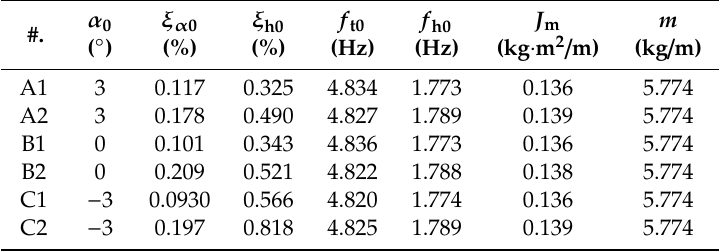
Figure 3. The flat closed-box bridge deck (unit: mm). Table 1. Main dynamic parameters of aeroelastic tests. α 0 is wind attack angle in still air; f t0 and f h0 are linear torsional and heaving frequency in still air, respectively. ξ α 0 and ξ h0 are linear mechanical damping ratios of the torsional and heaving modes. J m and m are the effective moment of inertia and mass per unit length, respectively, in the elastically supported vibration system.